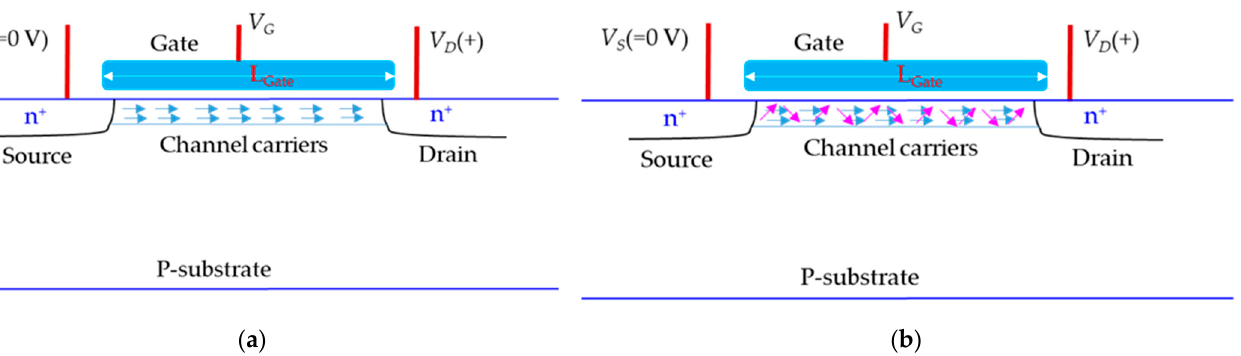
Figure 1. Channel carrier conduction due to drift effect in n-channel MOSFET (nMOSFET): ( a ) without gate bias or with smaller gate bias, and ( b ) with gate bias as a variable for long-channel device.